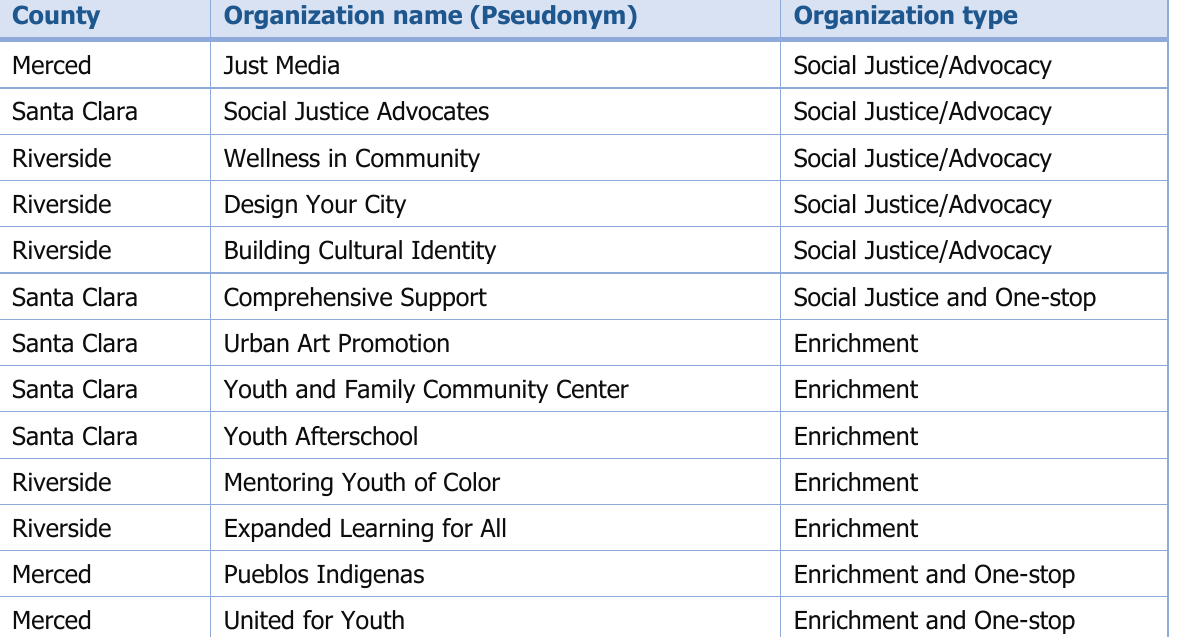
Table 1. Names and Type of Organizations